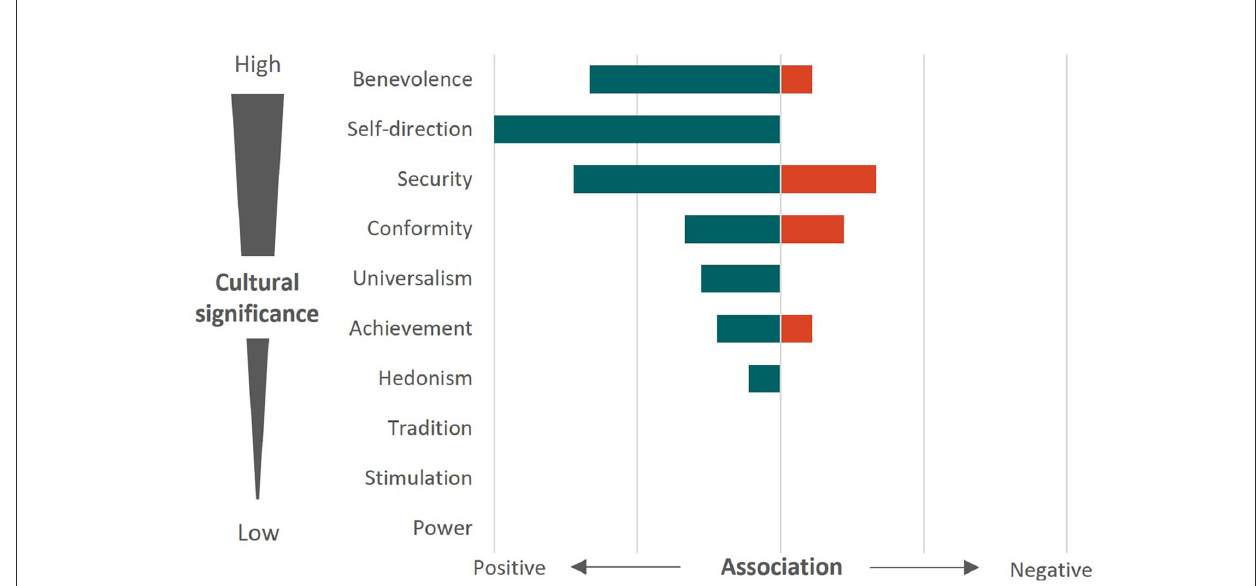
FIGURE9 Comparative occurrence of values expressed by Australian beef cattle farmers for the four primary biosecurity behaviors elicited from semi-structured interviews. Biosecuirty behaviors included isolating cattle, protecting farm boundaries, fomite control and prophylaxis. Green and red represent positive and negative associations,